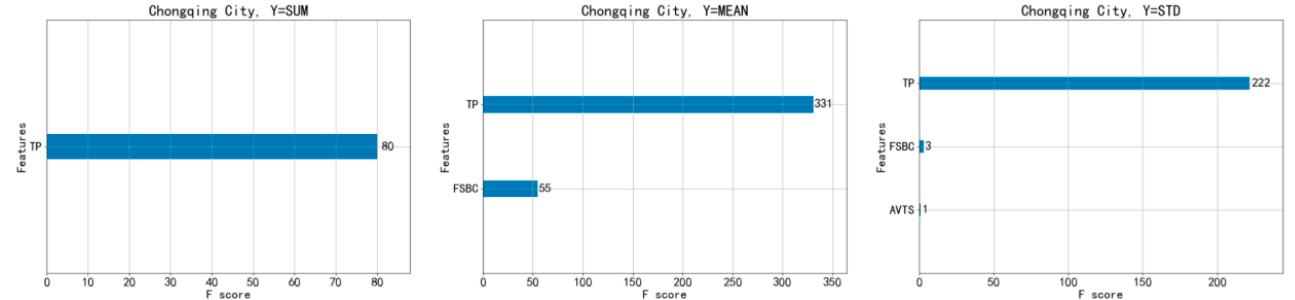
Figure 8. Results of decision tree regression at the Chongqing City scale.